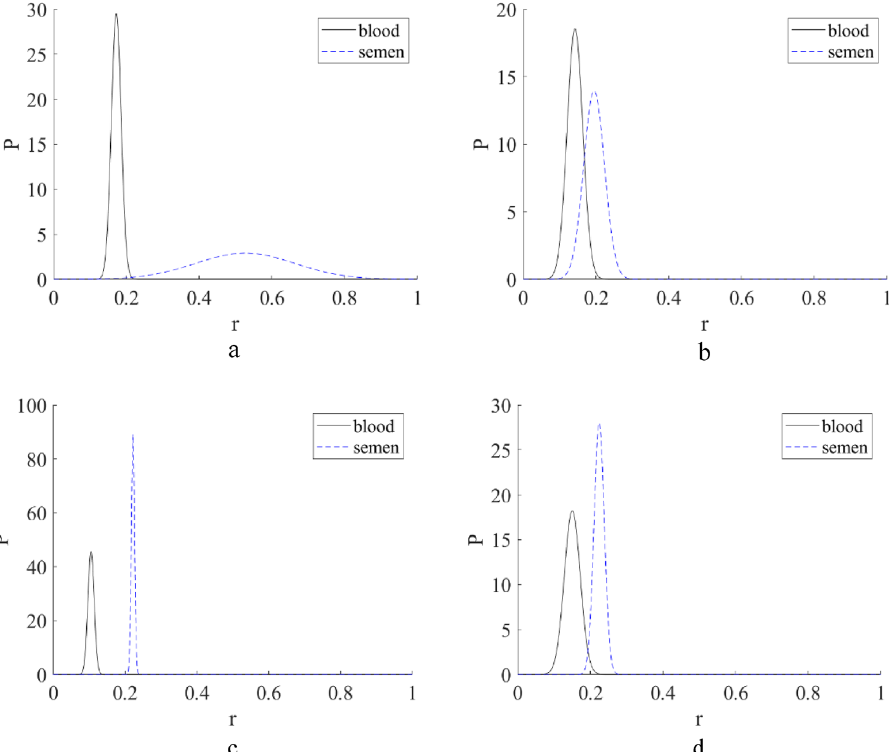
Figure 10. The probability density distribution of the proximity factor (9) for the residuals S R between the experimental Raman spectra of blood stain on a definite substrate and the Raman spectra of the same pure substrate in relation to the set S 0 of Raman spectra of blood and the set the seminal fluid Raman spectra of on an Al foil: blue polyester ( a ), denim ( b ), cotton fabric ( c ), and white polyester ( d )